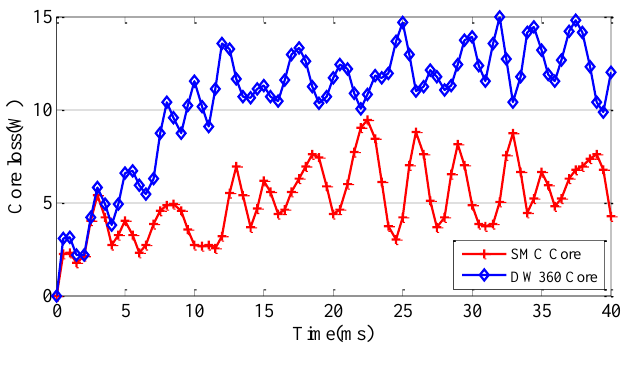
Figure 13. Core loss curves with different materials.